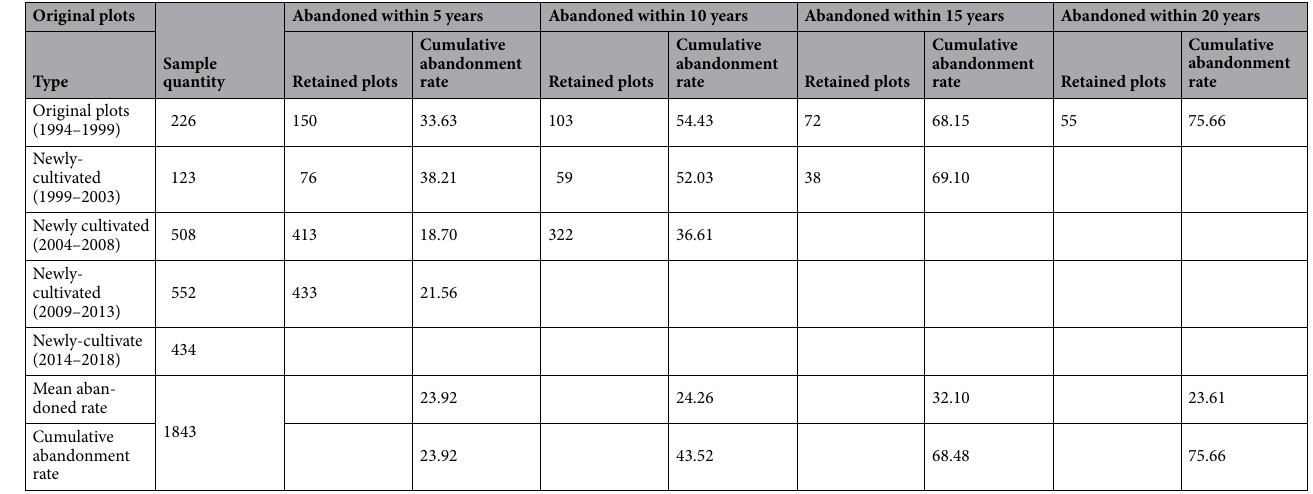
Table 7. Quantity (rates) of retained and abandoned sample plots after certain periods of plantation